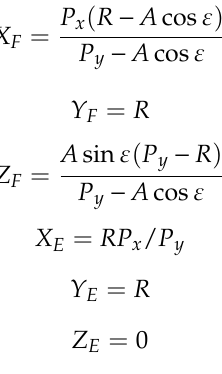
Figure 9. Shadow of an inclined pole on a horizontal plate.